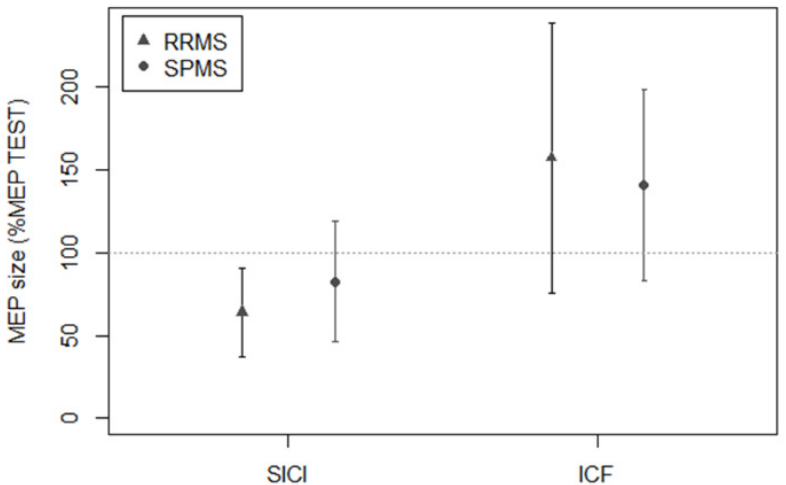
Figure 2. Transcranial magnetic stimulation assessment in subjects with RRMS and SPMS. SICI, as tested by paired-pulse stimulation with a 3 ms ISI, was significantly lower in SPMS than in RRMS. ICF, as tested by paired-pulse stimulation with a 10 ms ISI, was similar in RRMS and SPMS. Y axis: MEP size, expressed as conditioned MEP amplitude/test MEP amplitude × 100. Bars represent standard deviation.